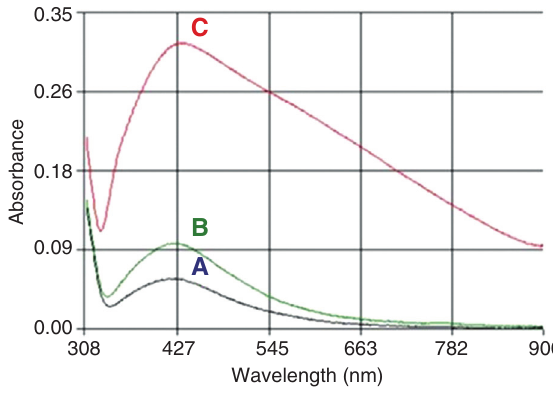
Figure 4: UV-vis absorption spectra of a reaction solution of silver nitrate (0.01 m), ethanol (96%), and ammonia (25%) sonicated for (A) 8 min, (B) 11 min, and (C) 25